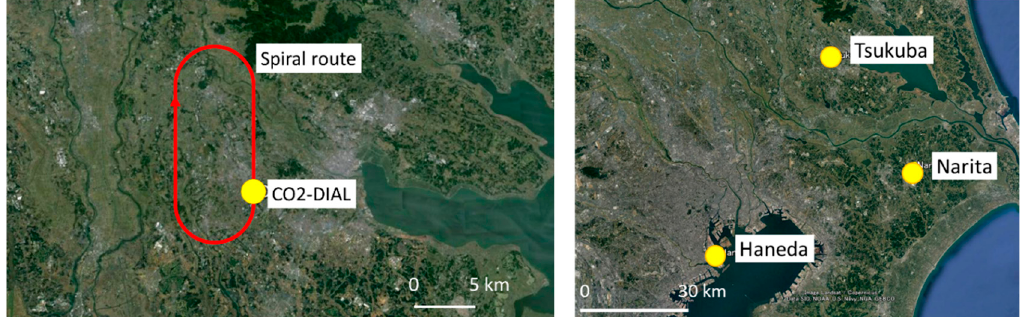
Figure 3. Observation sites where CO 2 DIAL ( right ) and aircraft measurements ( left ) were made on 12 January 2014 over Tsukuba.